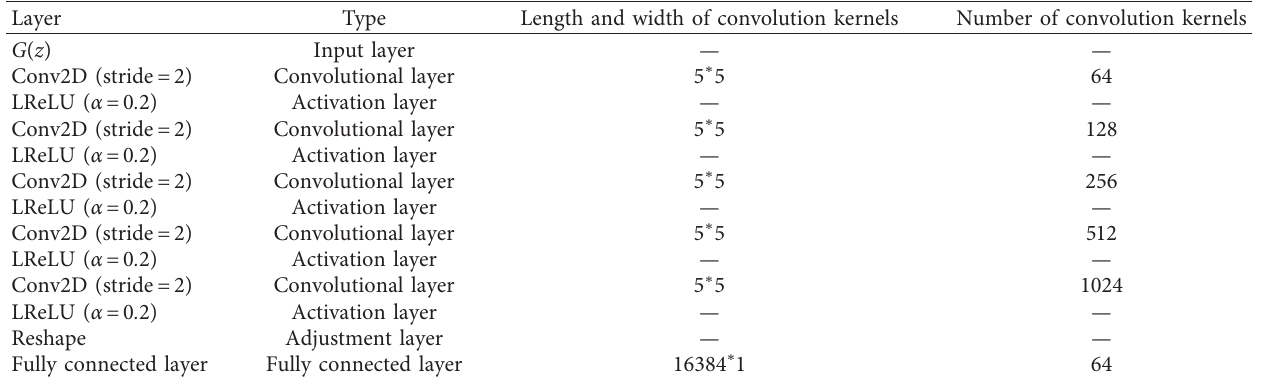
Table 4: Discriminator structure of the spectrogram GAN